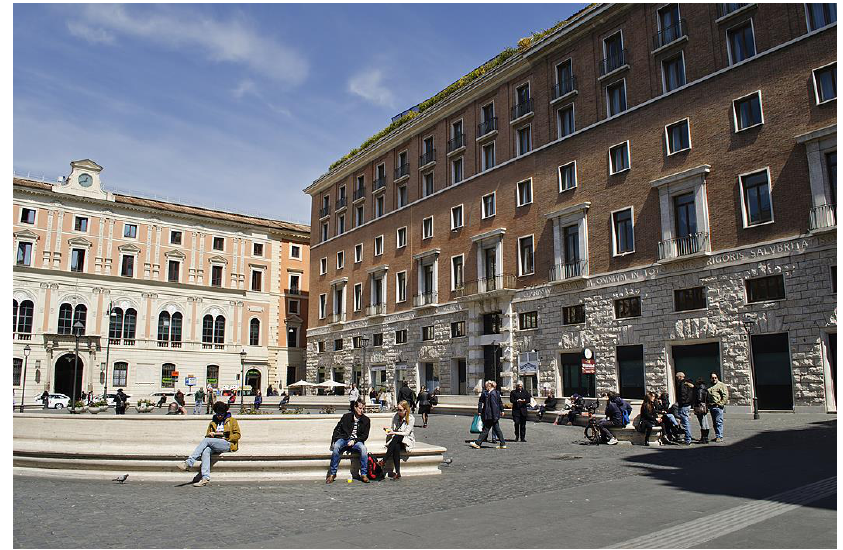
Figure 1. A picture of san Silvestro square taken in March 2015 (this is the reason for many visitors lingering on the sunny benches).